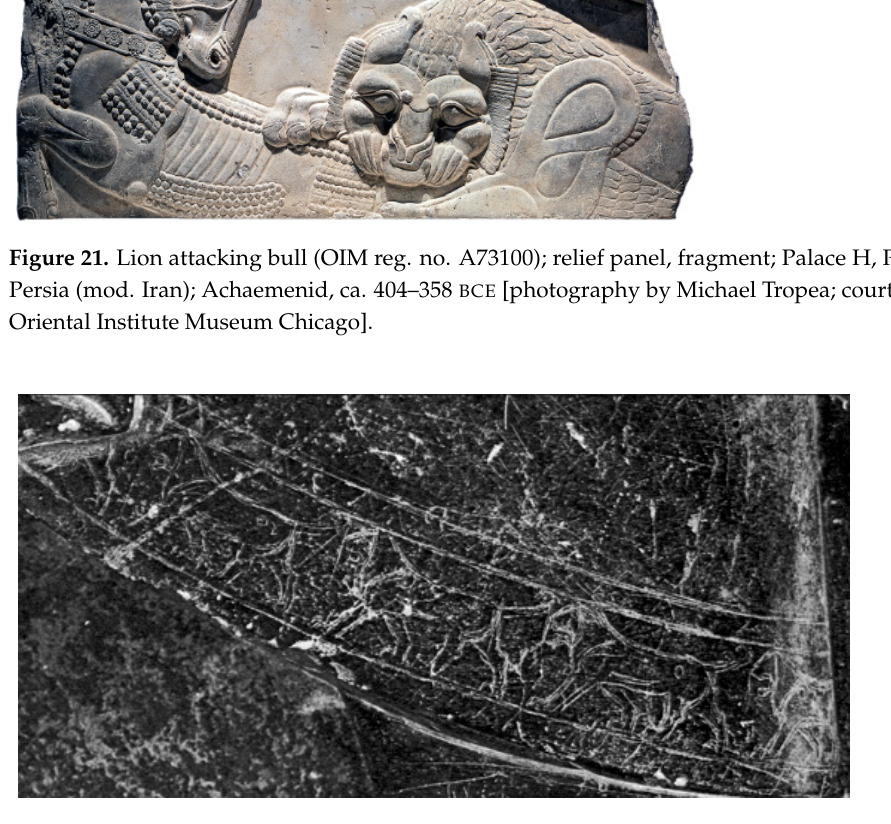
Figure 22. Design of lions on hem of Great King’s gown; relief, detail; Palace of Darius, Persepolis, Persia (mod. Iran); Achaemenid, ca. 518–486 BCE [image taken from Schmidt (1953), pl. 142a; courtesy of the Oriental Institute, University of Chicago].